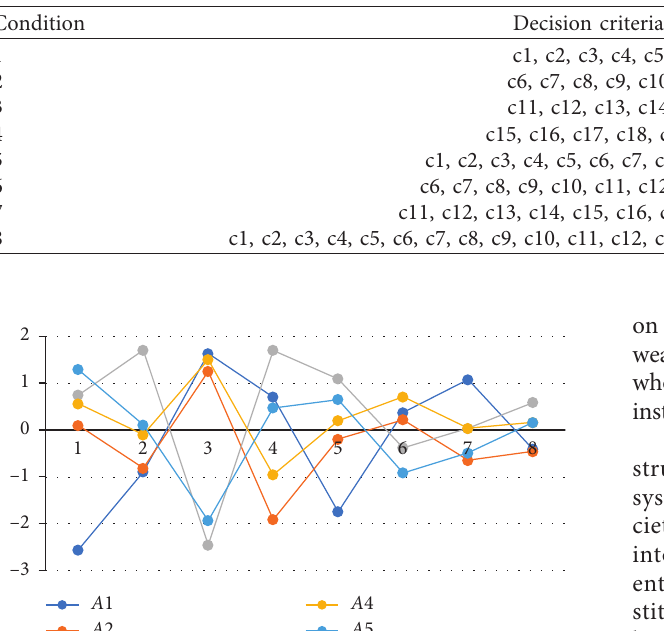
Table 15: Sensitivity analysis conditions comparison table.